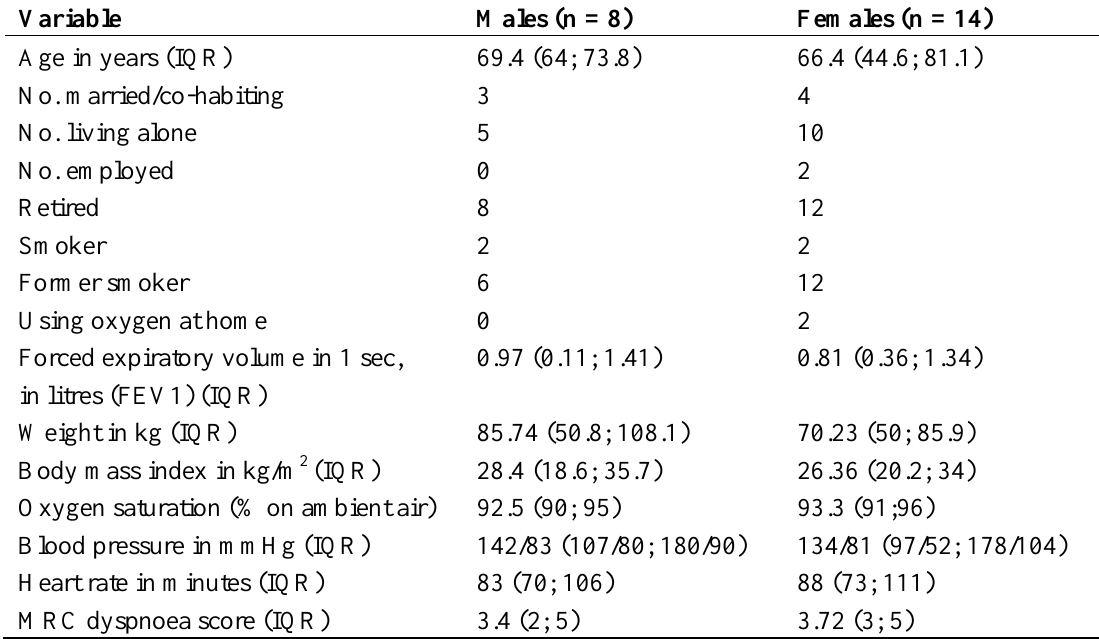
Table 3. Characteristics of patients interviewed in the TELEKAT study in interquartile range (IQR). Variable